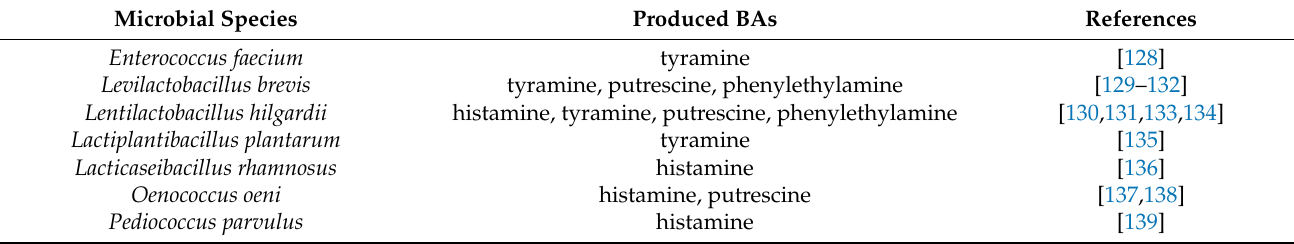
Table 3. A nonexhaustive list of biogenic amine (BAs)-producing LAB species in wine. Microbial